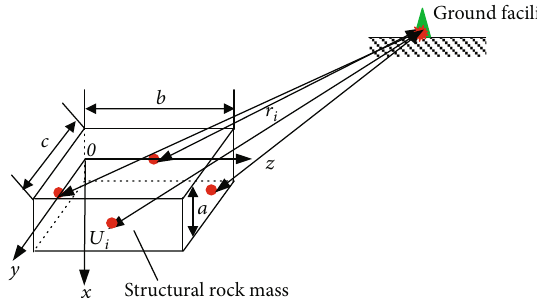
Figure 5: Simpli fi ed analysis of focal energy of the rock mass structure in the thick and hard rock